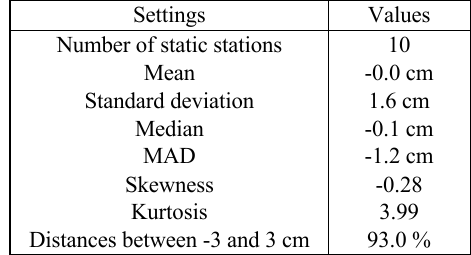
Table 5. References results for the vertical loop with all SLS stations and non-segmented MMS loop.